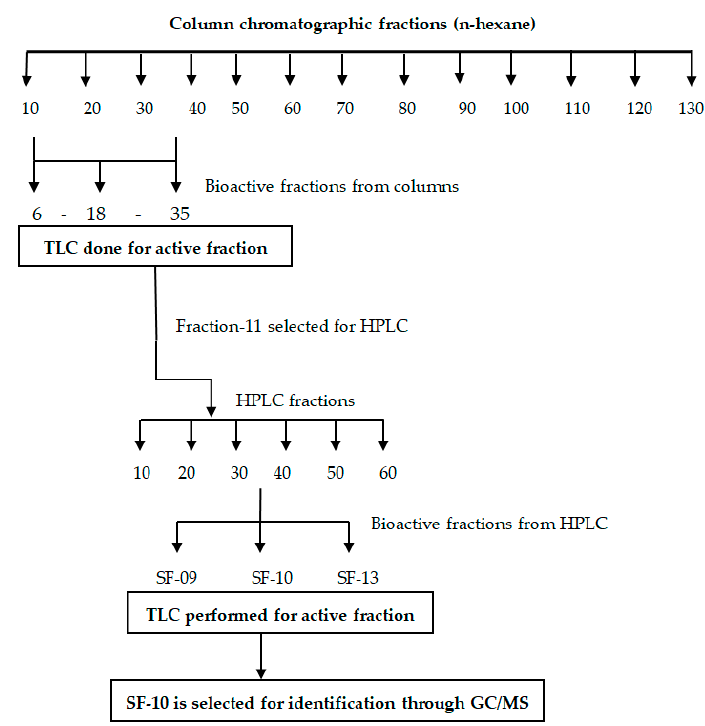
Figure 3. Summary of the identification scheme for the Figure 3 . Summary of the identification scheme for the compound.